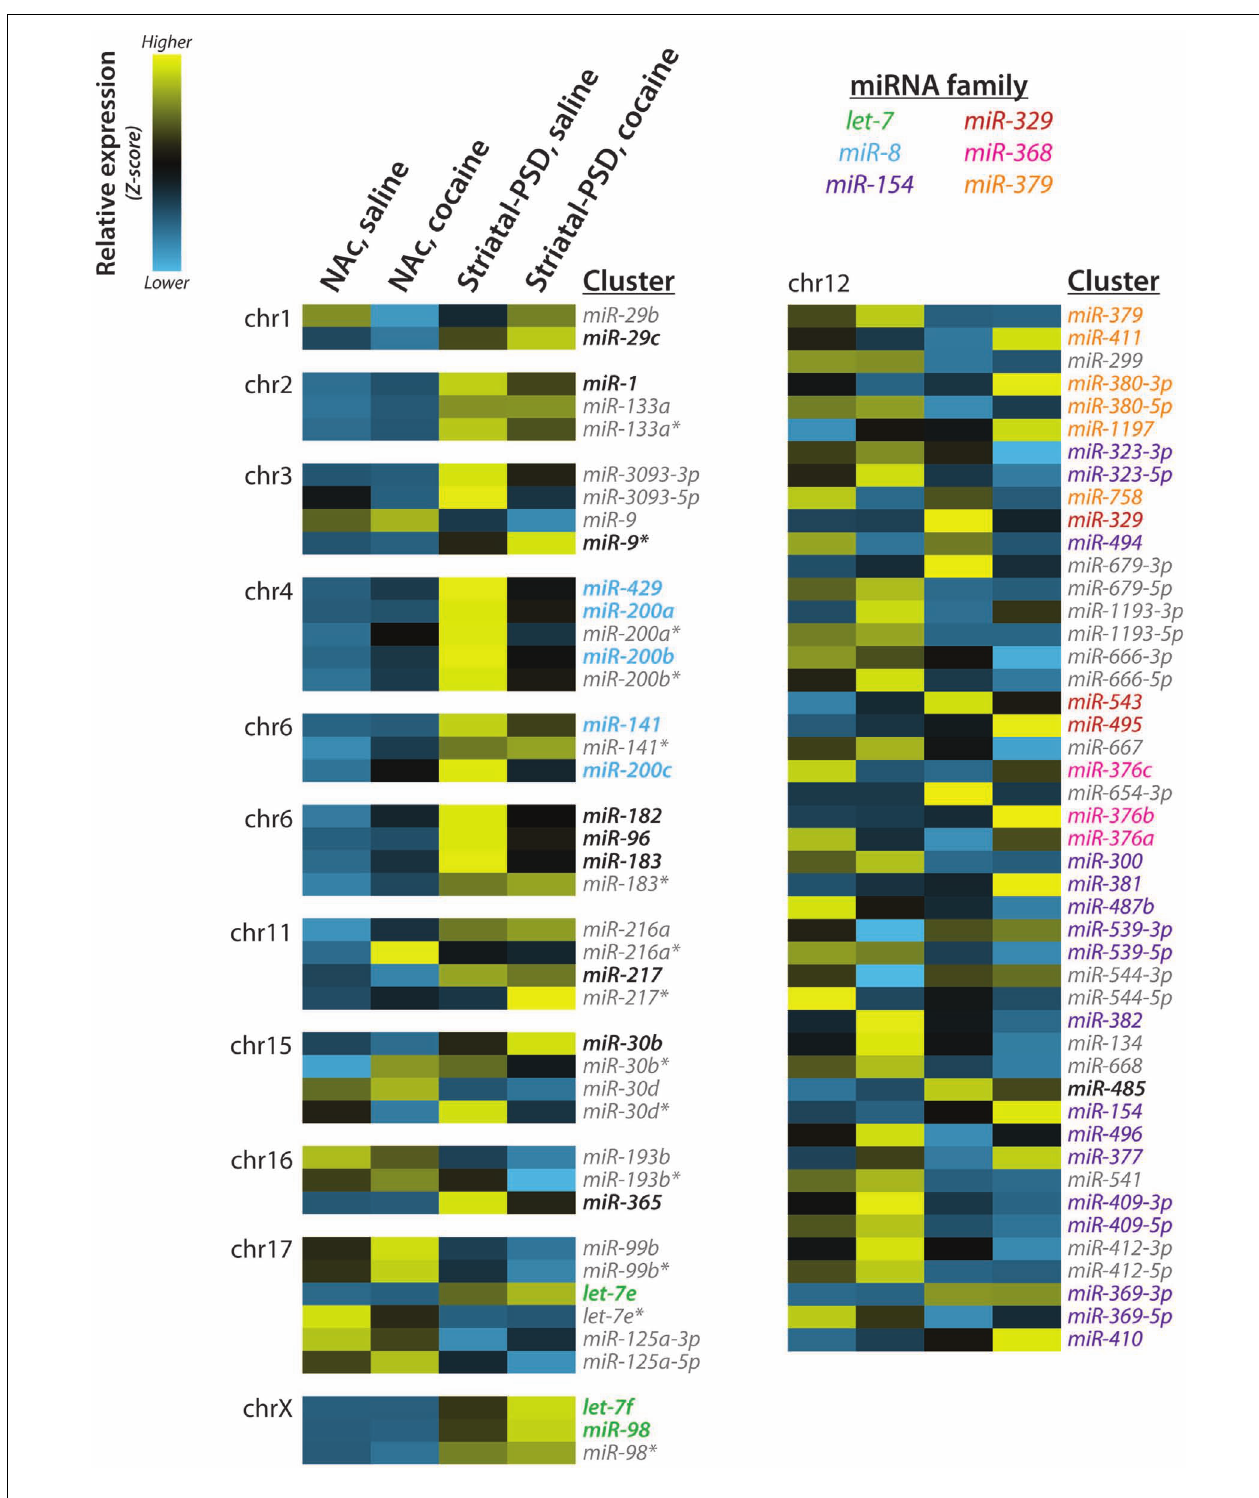
high expression. miRNA families are indicated by text color; PSD-enriched miRNAs are indicated by bold; miRNAs not enriched at striatal PSDs and/or not belonging to the listed miR families are shown in gray italic. Reproduced from Eipper-Mains et al. (2011) with